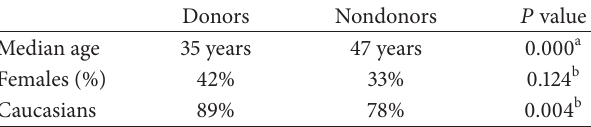
Table 3: Difference between donors and nondonors.